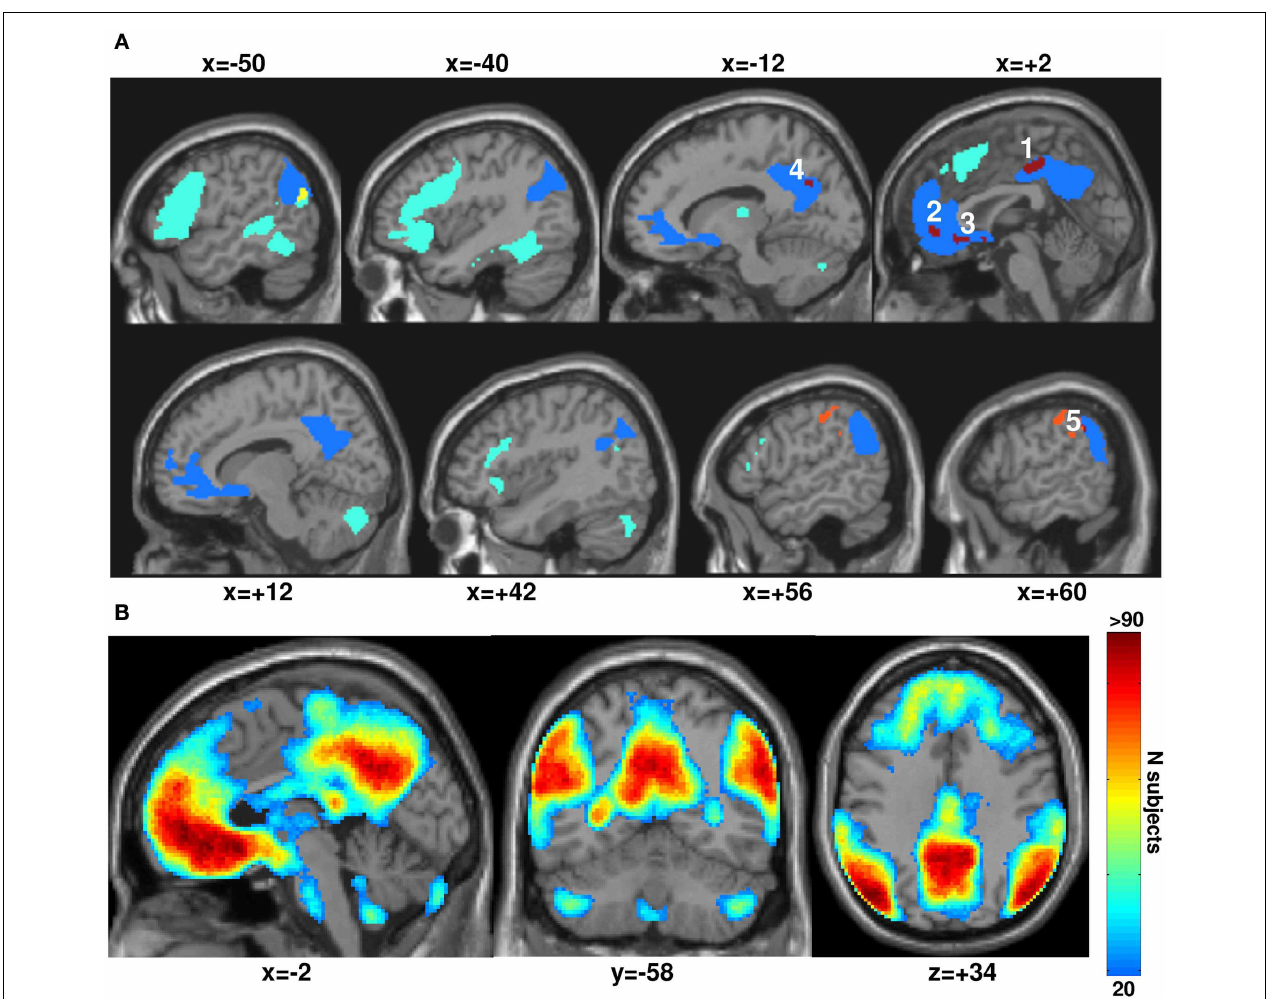
consistency, our five regions of interest (in dark red) are labeled with the same numbers as in Figure 4 and Table 1 . All significant voxels are projected on an individualT1-weighted image on sagittal views varying from x =− 50 to x =+ 60mm. (B) Overlap between the individual task-induced deactivations (DMN defined in each subject at a low threshold of p < 0.05 uncorrected). These percent of overlap maps measure how many subjects are deactivating each voxel of the DMN at a given individual threshold.Voxels in red are highly consistent across our 94